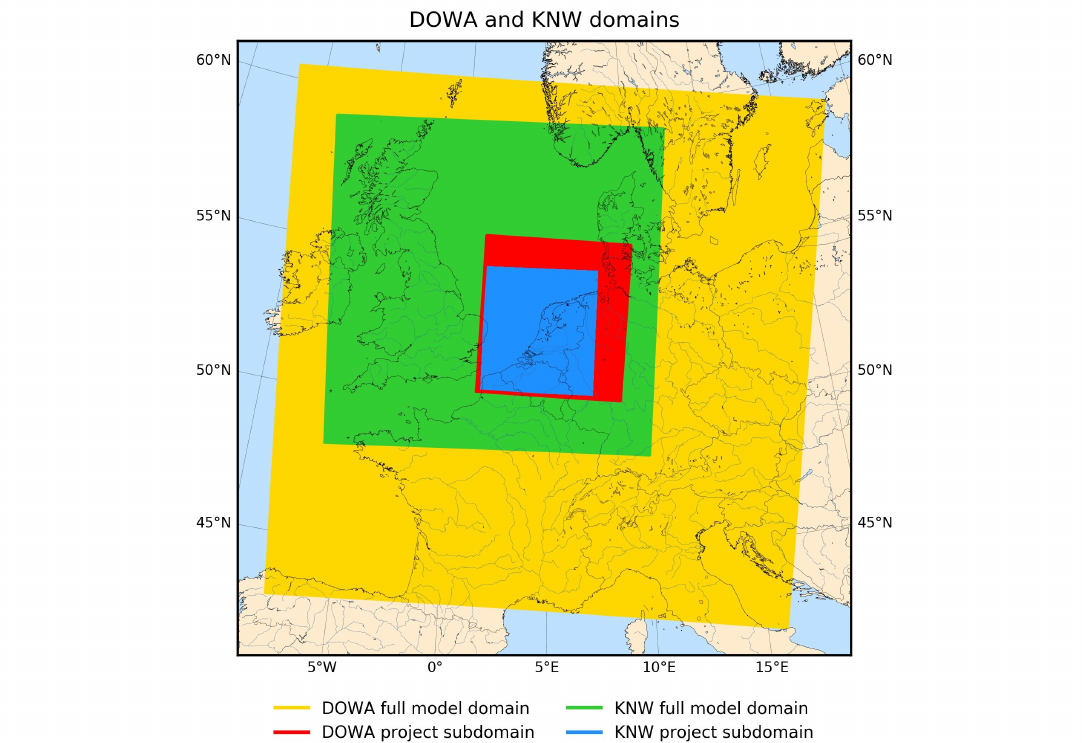
Figure 1. ERA5-HARMONIE domain (yellow) of 789 × 789 points and Dutch Offshore Wind Atlas (DOWA)-subdomain of 217 × 234 points (red). ERA-Interim-HARMONIE domain of 500 × 500 points (green) and KNMI North Sea Wind (KNW)-subdomain of 170 × 188 points